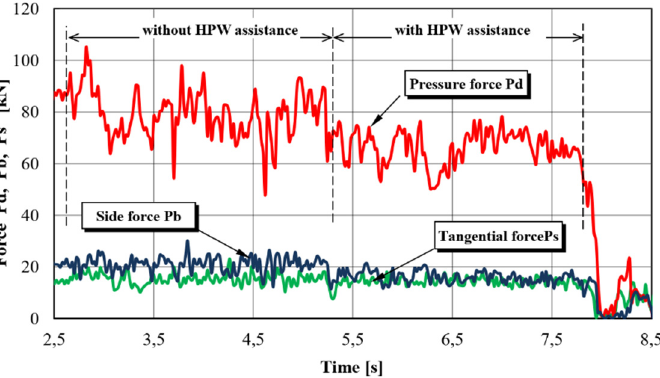
Figure 17. View of the exemplary course of Pd, Pb and Ps force values during mining with disk tool with and without high pressure water jet assistance—concrete sample compressive strength R c = 19.5 MPa, disk edge angle 2 β = 90°, mining radius R u = 250 mm, disk edge penetration depth h = 12.35 mm, slots depth g = 12.65 mm, slots spacing 2B = 80 mm [1].